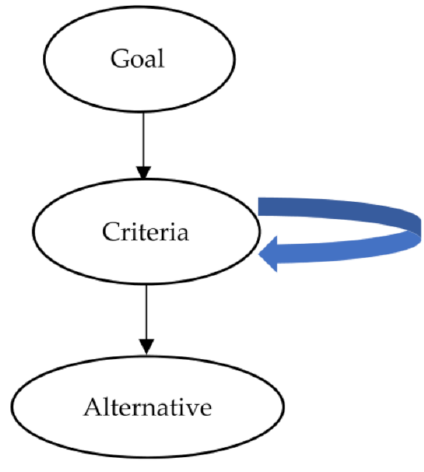
Figure 2. The framework of the